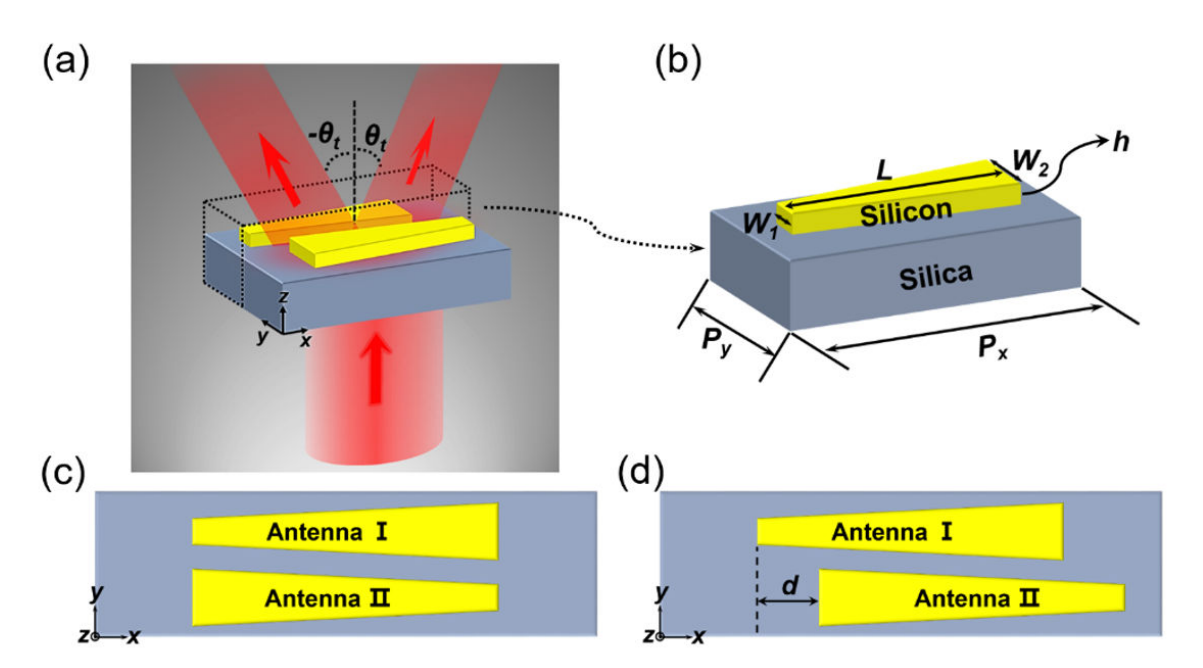
Figure 2. ( a ) Schematic of the proposed metasurface-based beam splitter. ( b ) The three-dimensional structure diagram of a supercell, consisting of only one trapezoidal silicon antenna placed on the silica substrate. The design procedure of the beam splitter (vertical view). In a supercell, ( c ) these two identical antennas that form a supercell are aligned in the y-direction, ( d ) The antenna II is shifted by d along the positive x-axis with respect to antenna